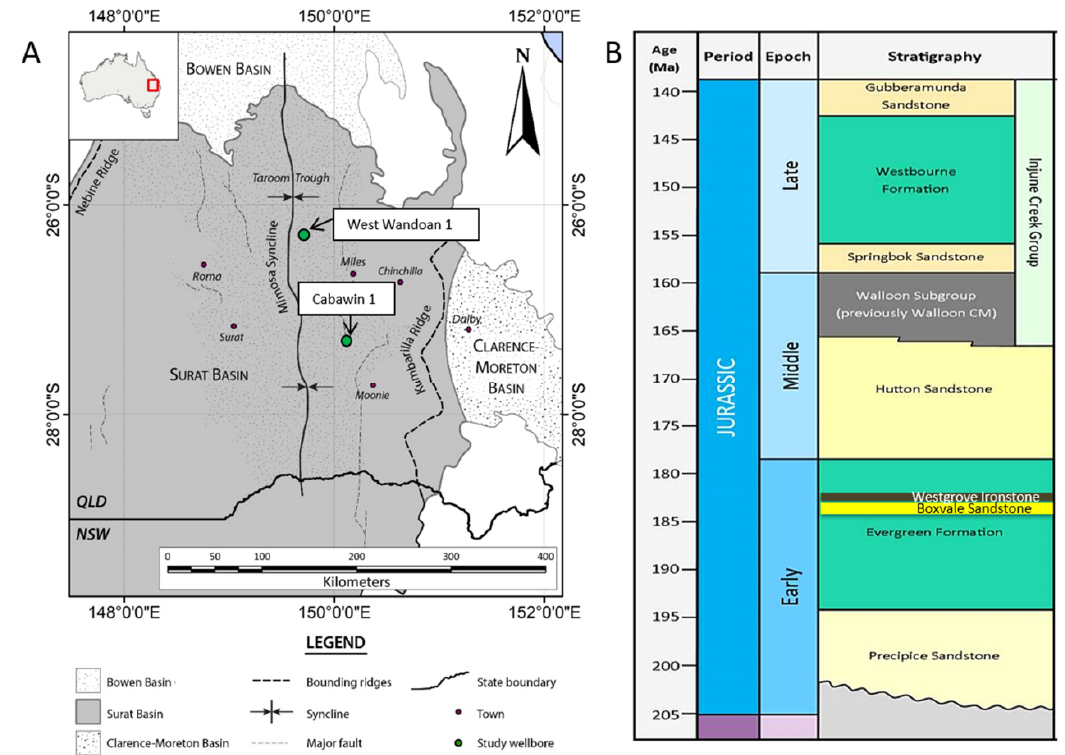
Figure 1. ( A ) Map of the Surat Basin, Australia, also showing the Bowen Basin and Clarence Moreton Basin. The West Wandoan 1, and Cabawin 1 wells are marked in green; ( B ) Generalized stratigraphic column showing the Precipice Sandstone and overlying Evergreen Formation.